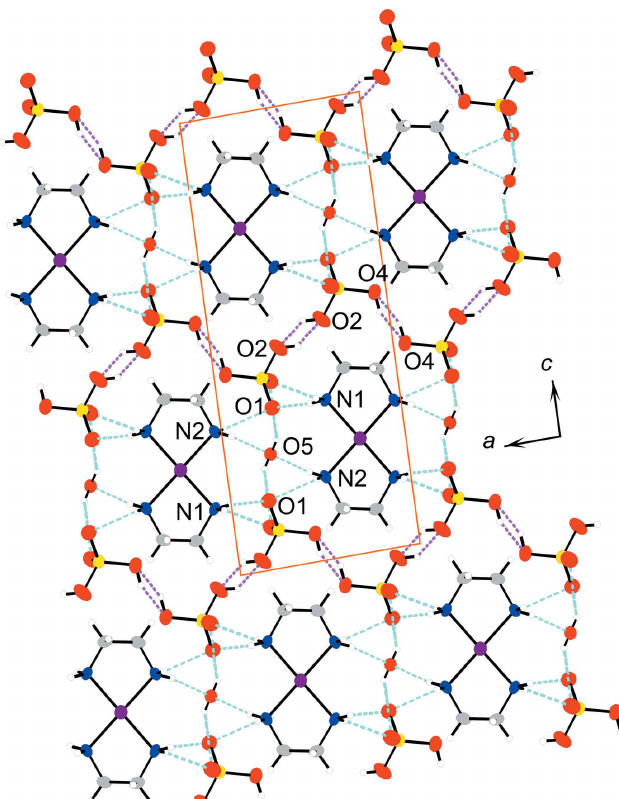
Figure 2 Aview of the columnar structure of compound (I), running parallel to the b axis. Displacement ellipsoids are drawn at the 50% probability level for non-H atoms. The violet hollow ellipsoids of I atoms and the violet hollow lines between Pt and I atoms represent the disordered part of the (cid:2)(cid:2)(cid:2) I— Pt IV —I (cid:2)(cid:2)(cid:2) Pt II (cid:2)(cid:2)(cid:2) chain. Light-blue dashed lines represent hydrogen